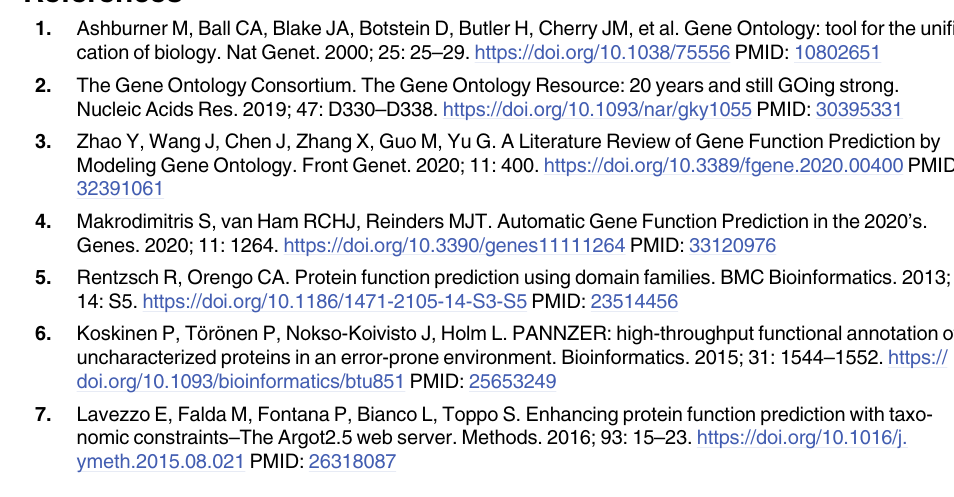
Bars at the top of each panel show the total numbers of proteins annotated with at least one GO term for each respective annotation dataset, with white-filled areas showing the remaining pro- teins with no annotations. Split violin plots show the distributions of the numbers of GO Slim terms annotated per protein (purple, left), and summed leaf+parents information content (IC) per protein (green, right). Y-axes are limited to a maximum of value of 300 for total protein IC distributions. The boxplots show the medians and 1.5 times the interquartile range for the num- bers of GO Slim terms annotated per